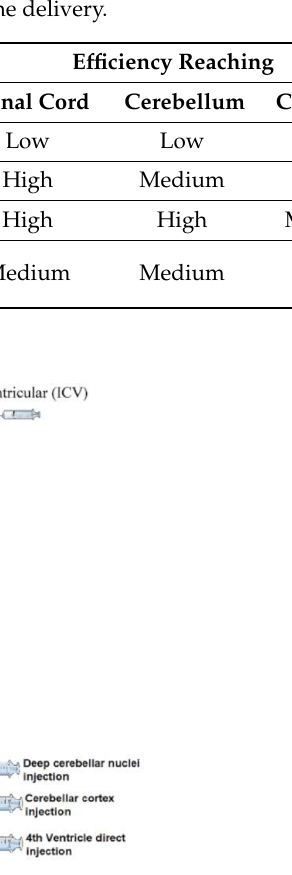
Figure 1. Different routes of administration used in gene therapy for CNS delivery. ( a ) Routes of deliv- ery implemented clinically (IV, IT, ICV) or in the progress of being implemented (ICM). ( b ) Preclinical routes of gene delivery used in mice. IV: intravenous. IT: Intrathecal. ICV: Intracerebroventricular. ICM: Intra-cisterna